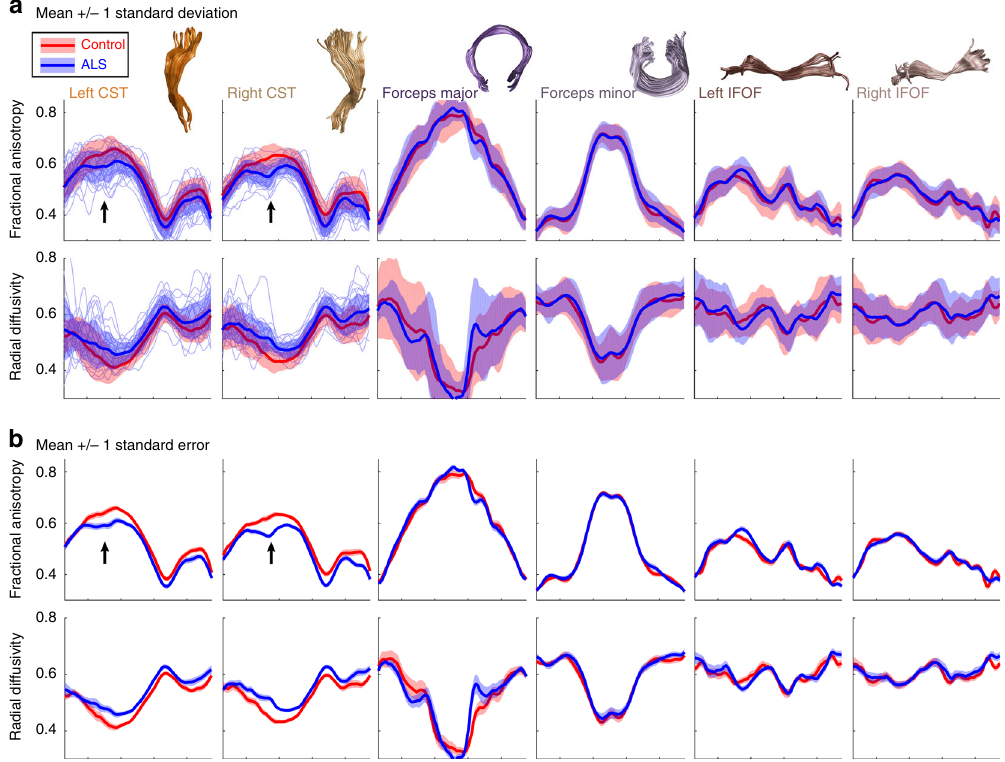
Fig. 4 Amyotrophic lateral sclerosis patients show isolated degeneration of the corticospinal tract. a Means and standard deviations of FA and RD values are shown for ALS patients (blue) and control subjects (red). Individual patients are displayed as light blue lines for the CST. At the level of the cerebral peduncle, patients differ from controls by more than 1 standard deviation (black arrow). No other tracts show this large effect. b Means and standard errors are shown for ALS and control subjects to indicate regions of signi fi cant group differences. Group differences are relatively speci fi c to the CST (see Figure5_ALS.m and